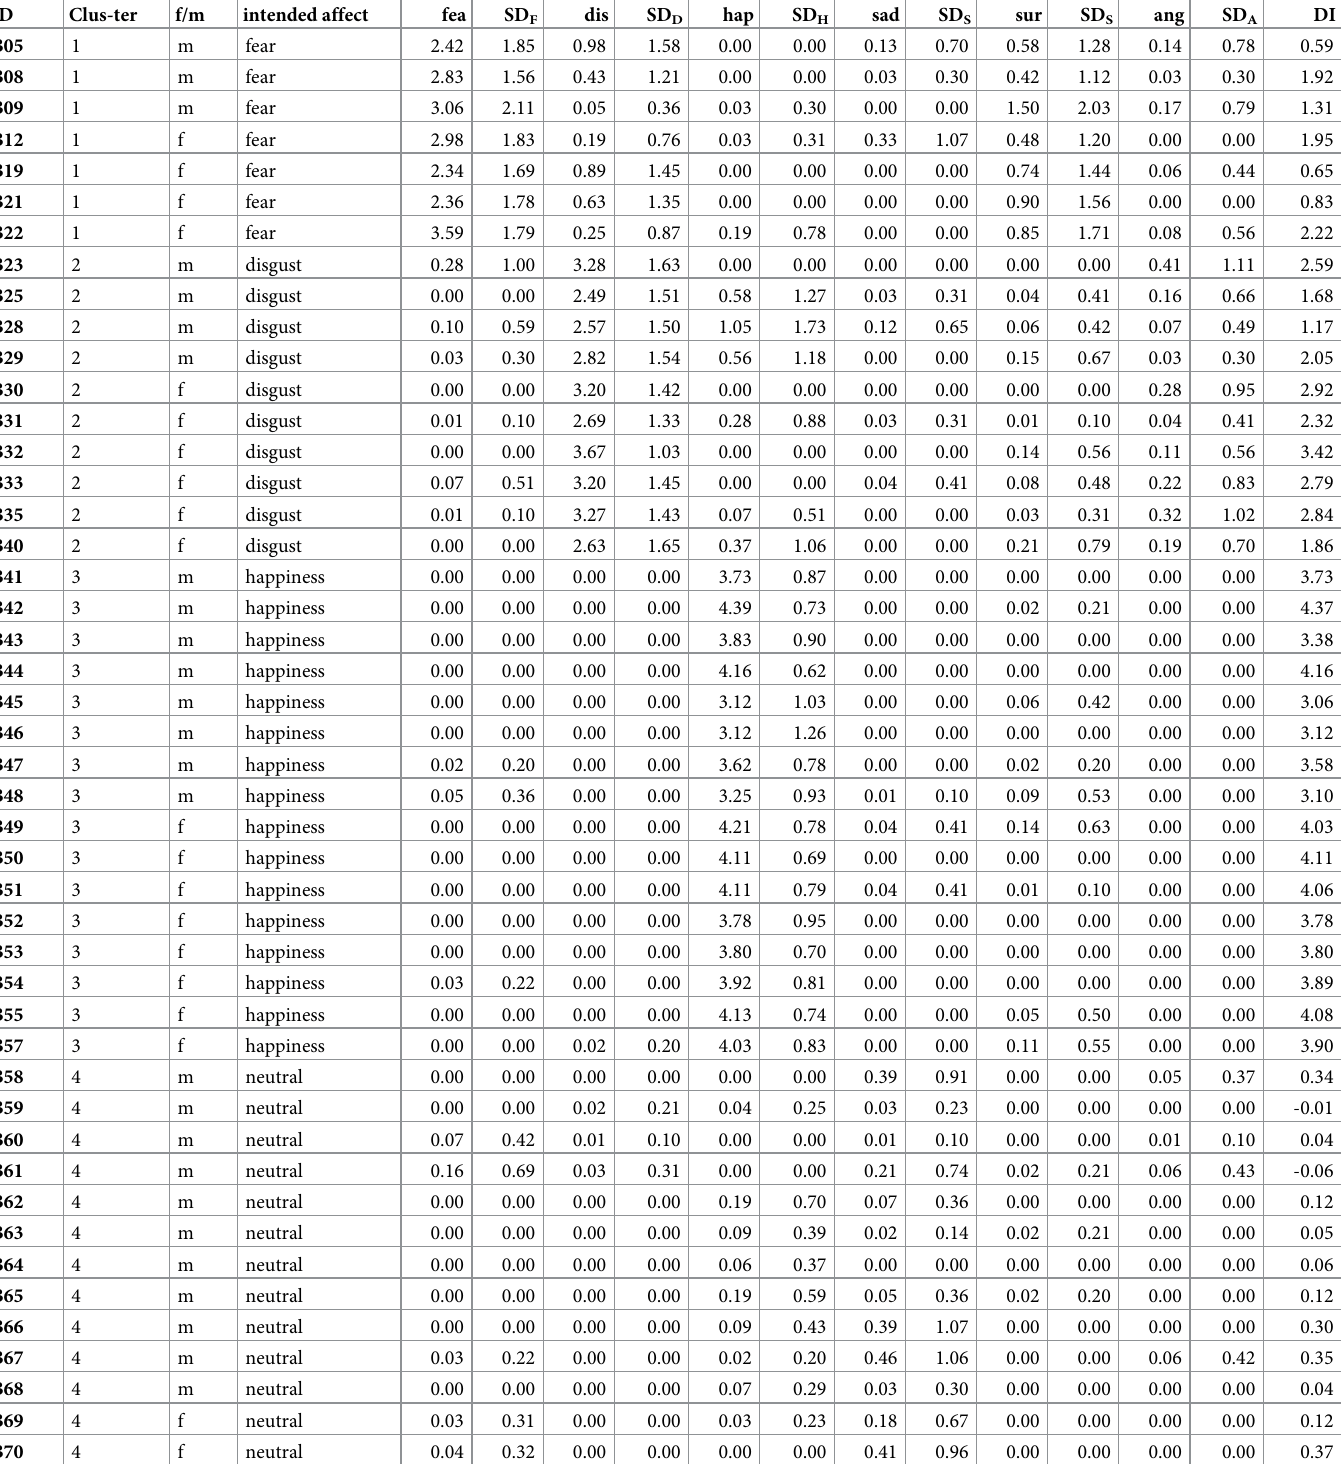
Table 1. Rating of intensity of each basic affect and index of difficulty (range 0 to 5; difference between the highest affect rating and the added four other affect rat- ings) of the 104 individual affect expressive portraits of children and their distribution to the final 7